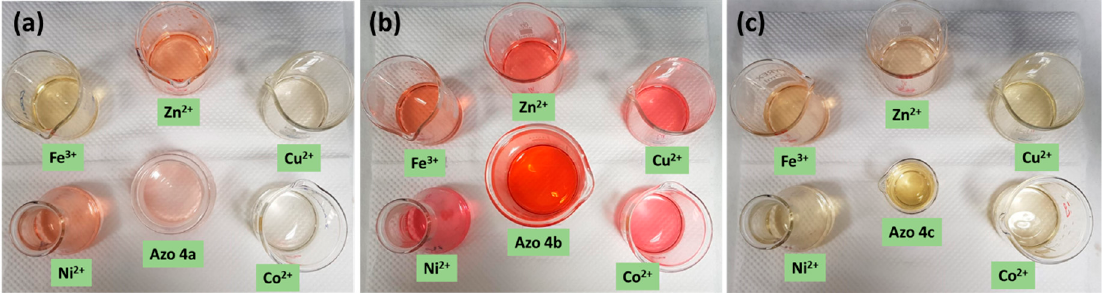
Figure 2. Color change of azo 4a (a), azo 4b (b) and azo 4c (c) (2.5 × 10 − 5 M) upon addition of four equivalents of different metal ions.